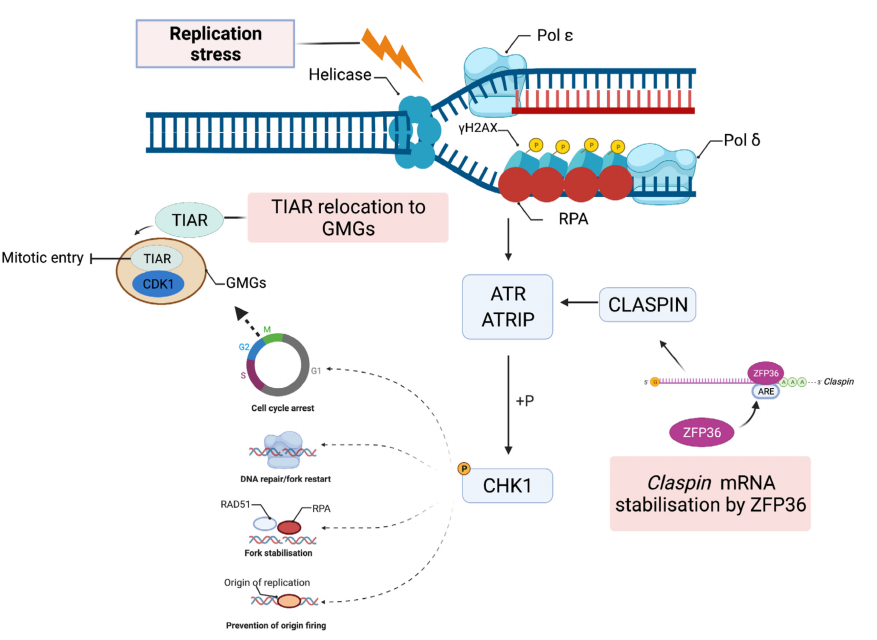
Figure 2. AU-RBPs at the nexus of the replication stress response. The eukaryotic replicative helicase complex unwinds parental DNA enabling replication of the leading and lagging strands by DNA polymerase Pol ε and Pol δ respectively. Replication stress can result in stalled replication fork progression (orange bolt) leading to stretches of single-stranded DNA (ssDNA) as the DNA continues to unwind. ssDNA becomes bound and protected by the ssDNA binding protein replication protein A (RPA), initiating ATR kinase recruitment. ATR recruitment is facilitated by interactions with ATR interacting protein (ATRIP), resulting in downstream activation of factors involved in the resolution of compromised replication forks. For ATR to phosphorylate its primary target, the master regulator CHK1 and CLASPIN must bind to RPA enabling phosphorylation of CHK1 at serine residues 317 and 345. This is accompanied by the phosphorylation of H2A histone family member x (H2AX) at serine 139 ( γ H2AX) early in the replication stress response. Activation of CHK1 ensures faithful restoration of the replication fork by initiating cell-cycle arrest, preventing origin firing, promoting fork stabilisation, DNA repair, and fork restart. The AU-RBP ZFP36 has been reported to be a key component in mediating faithful activation of CHK1 by ATR, by increasing the stability of CLASPIN mRNA. AU-RBP TIAR has been linked to arresting cell cycle at the G2/M border in response to replication stress by attenuating CDK1 in G2/M transition granules (GMGs) inhibiting entry into mitosis (discussed